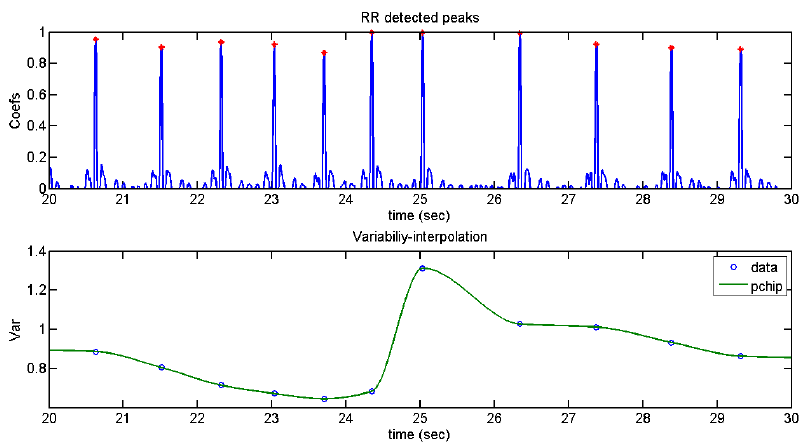
Figure 16. User 2 heart rate variability.